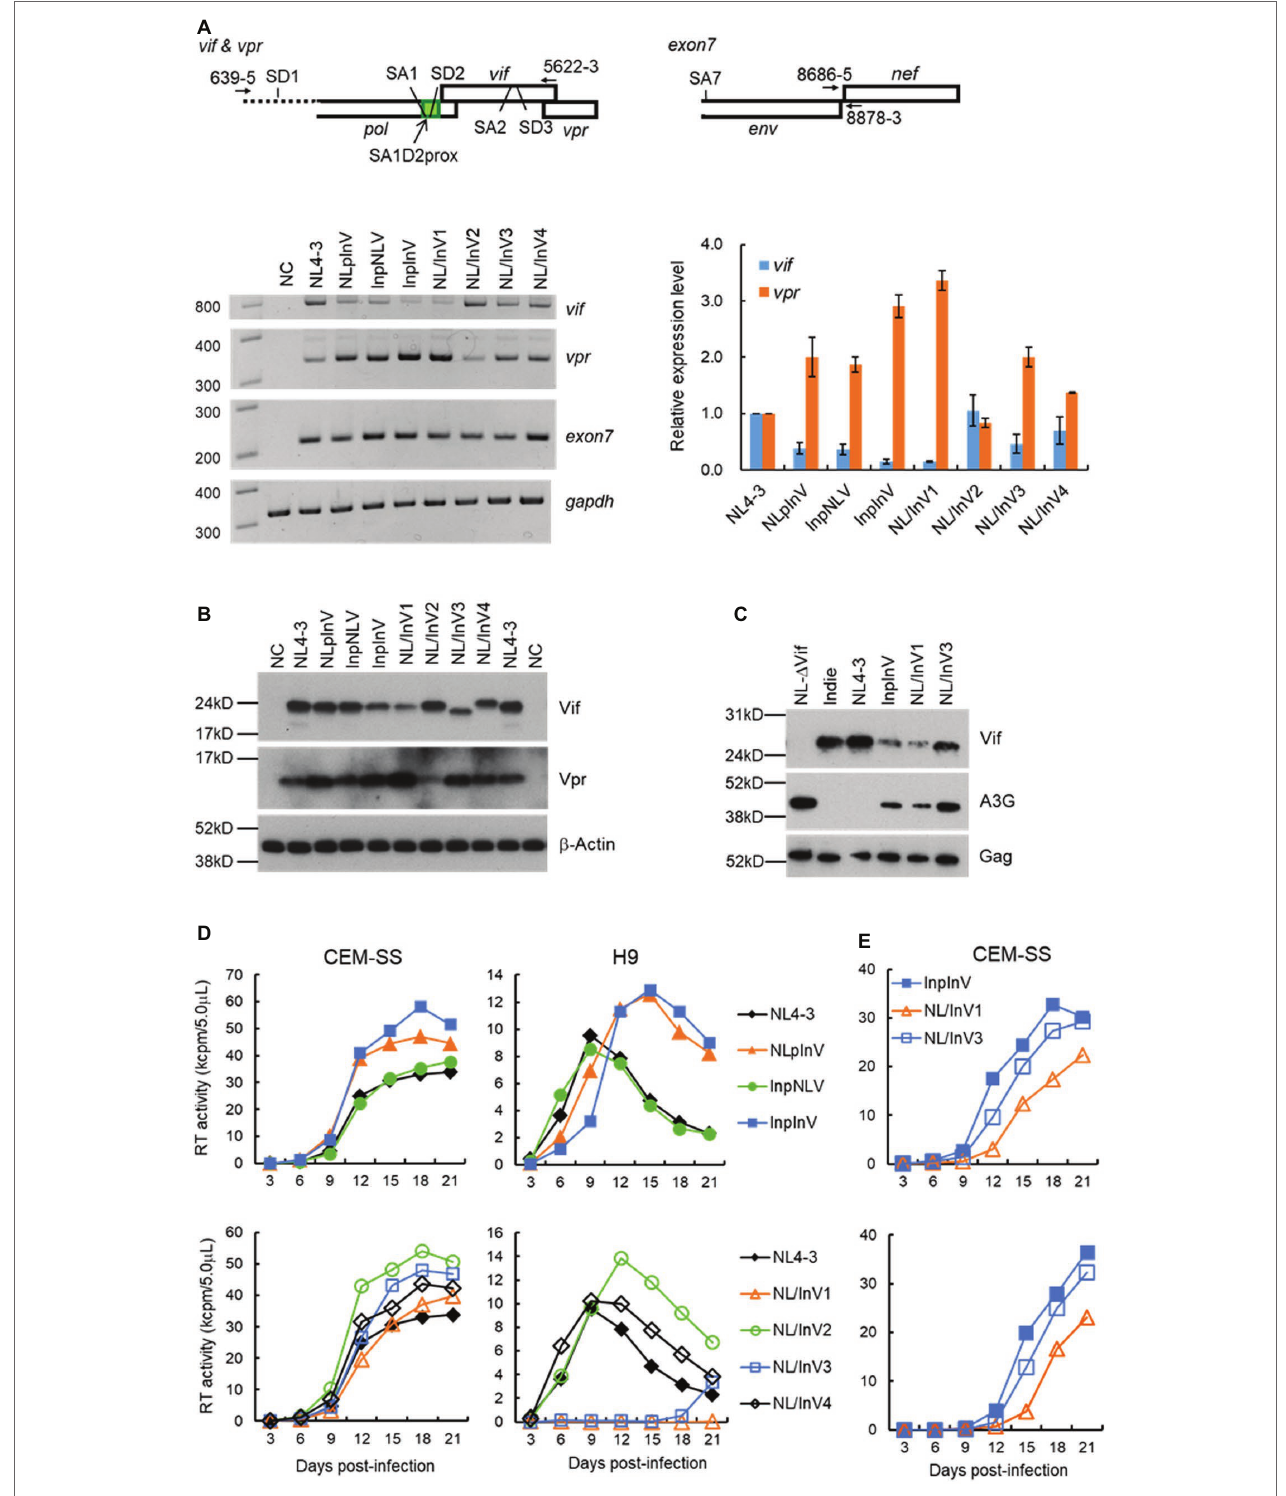
FIGURE 2 | Virological characteristics of NL4-3 and chimeric viral clones newly constructed. Most experiments here were performed similarly as described previously (Nomaguchi et al., 2014, 2016, 2017). (A) Semiquantitative PCR analysis. Indicated proviral clones (2.5 μ g) were transfected into 293T cells by Lipofectamine 2000 (Thermo Fischer Scientific), and cell lysates were made at 18 to 20 h post-transfection. Total RNAs were prepared and subjected to cDNA synthesis with